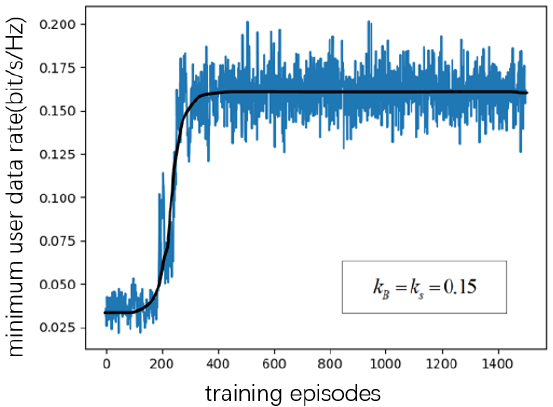
Figure 10. Convergence Speed when k B = k S = 0.15.